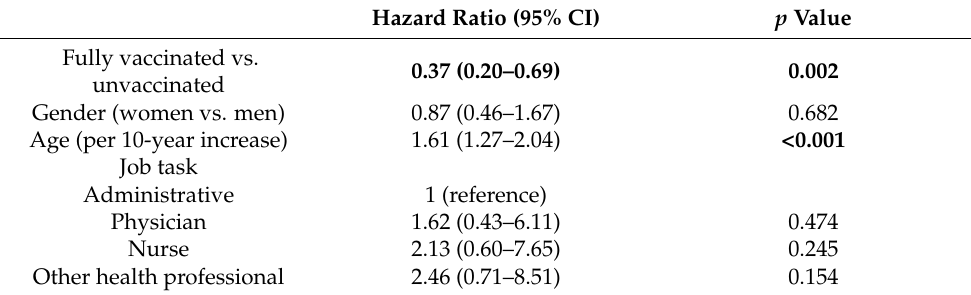
Fully vaccinated